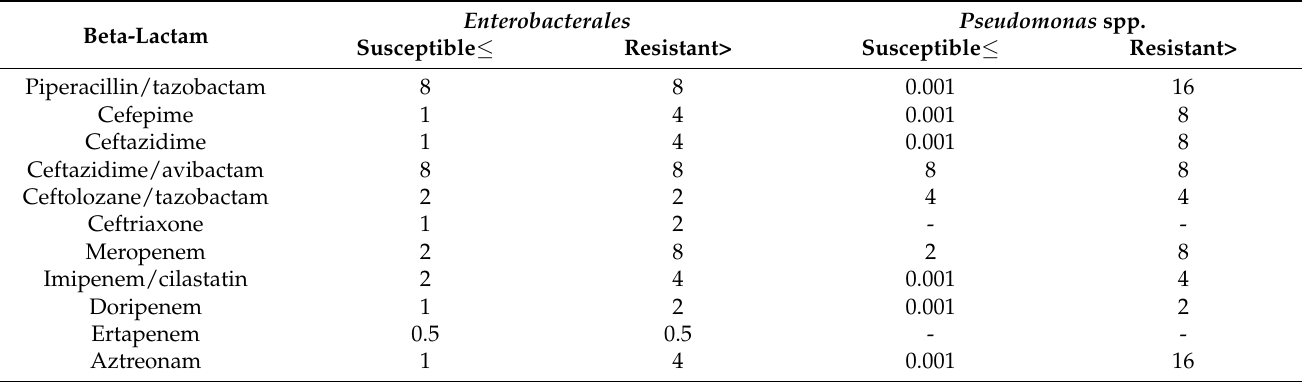
Table 1. EUCAST MIC breakpoints 1